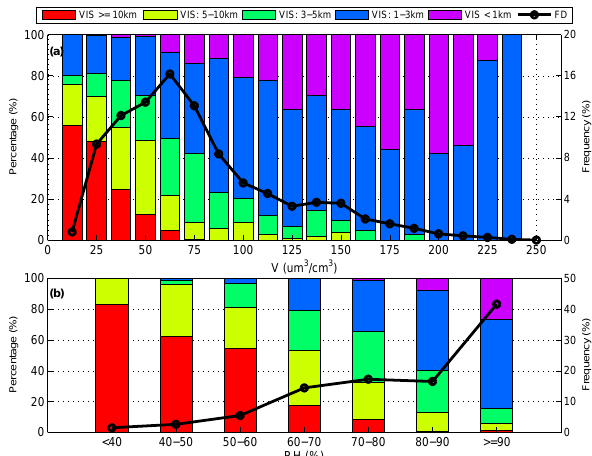
Fig. 2. Percentages of five specific visibility groups at different aerosol (a) volume concentration ( V ) and corresponding (b) RH ranges, as well as their corresponding frequency distribution (FD) presented in dotted dark lines; the colored bars stand for the sit- uation of corresponding visibility groups (VIS > = 10km, 5km = < VIS < 10km 3km = < VIS < 5km, 1km = < VIS < 3km and VIS <